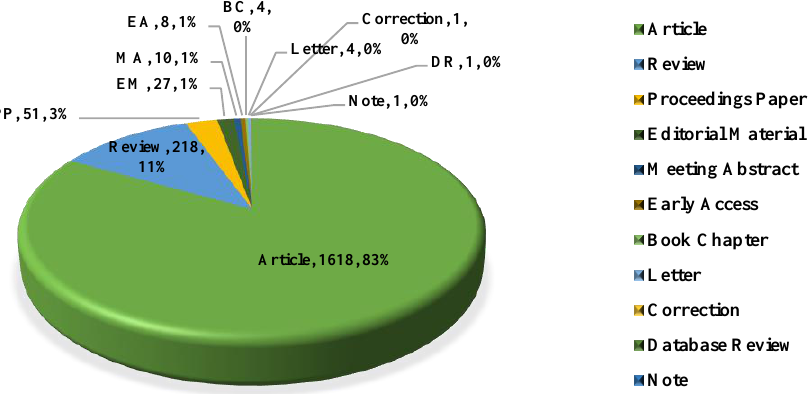
Figure 2. Publications types in the field of prediction of infectious diseases.